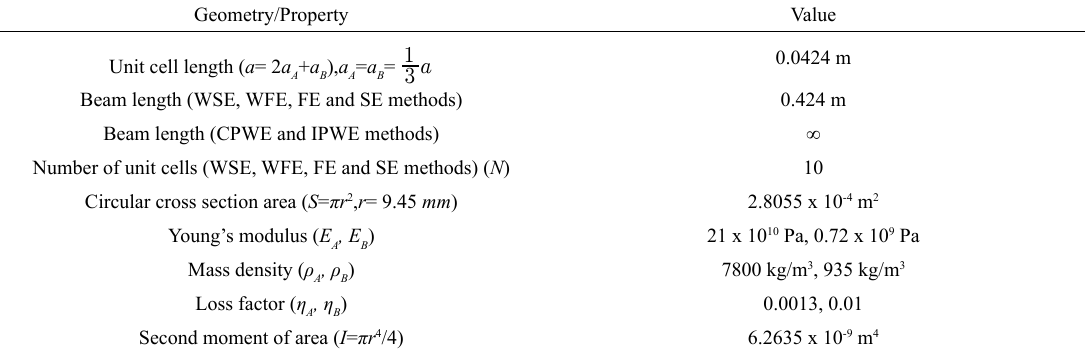
Table 1. Beam geometric parameters and material properties.